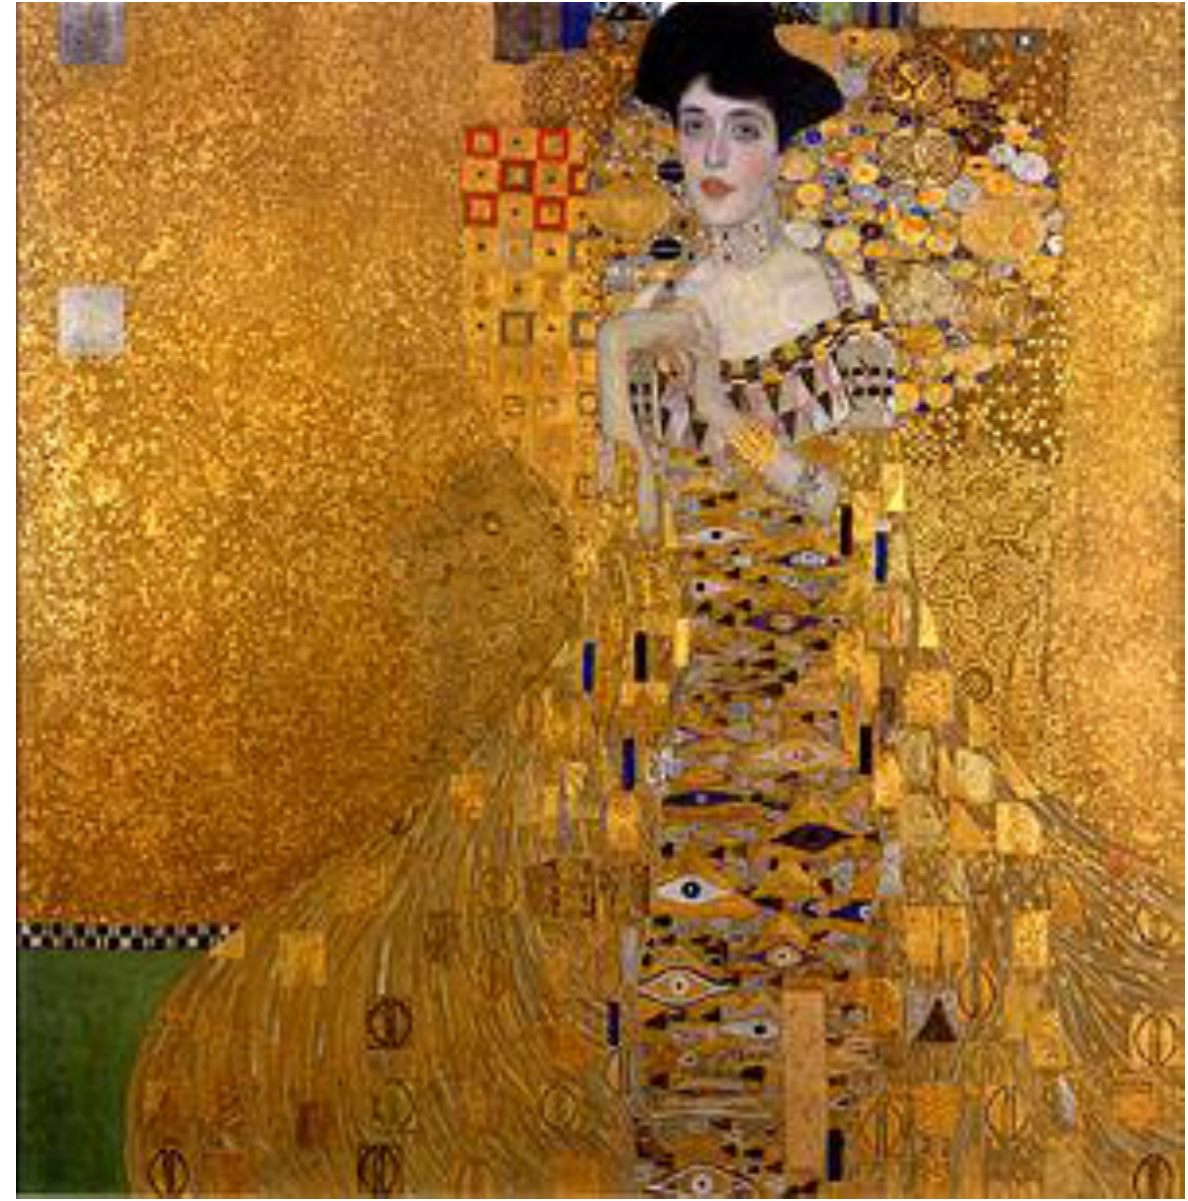
Figure 3. August Klimt’s “ Portrait of Adele Bloch-Bauer I